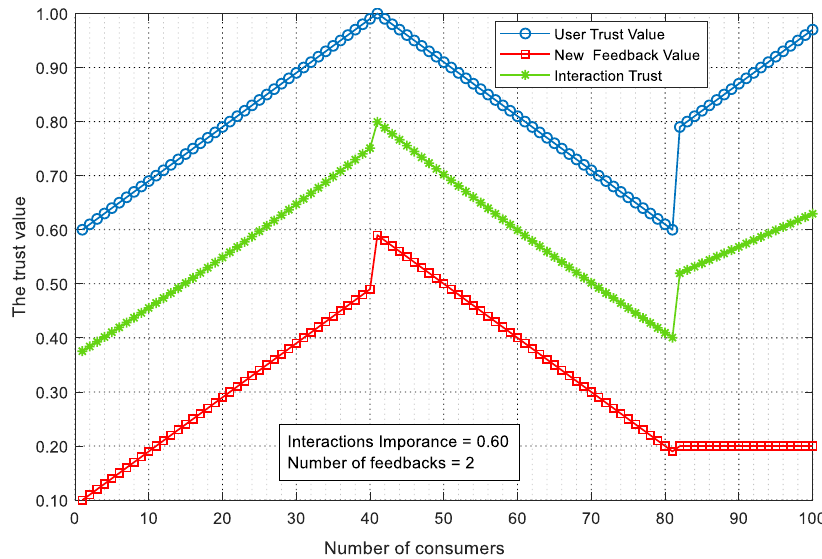
Table 1. Collusion attack frequency. Figure 4. Interaction trust values for 100 malicious consumers. Figure 4. Interaction trust values for 100 malicious consumers.